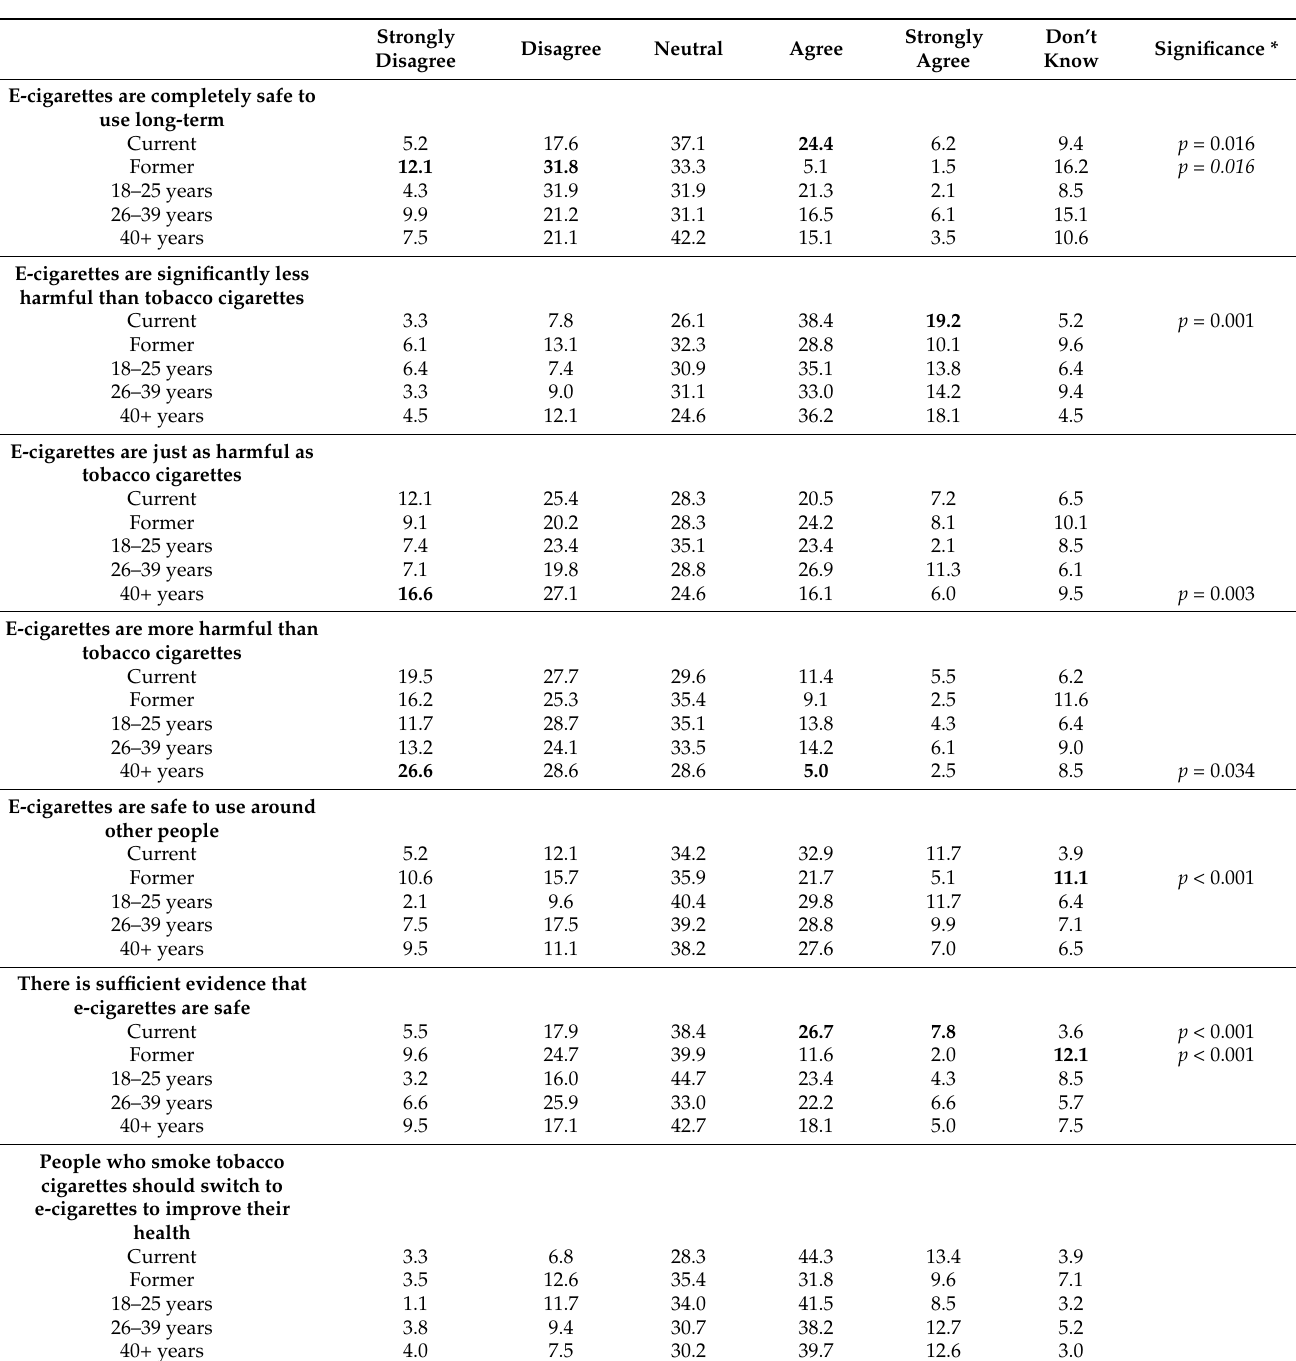
Table 3. Perceptions around e-cigarette safety stratified by current and former e-cigarette users and by age. Data presented are percentages. Numbers in bold indicate significantly greater than expected compared within current/former e-cigarette user, or within a particular age category. Sample